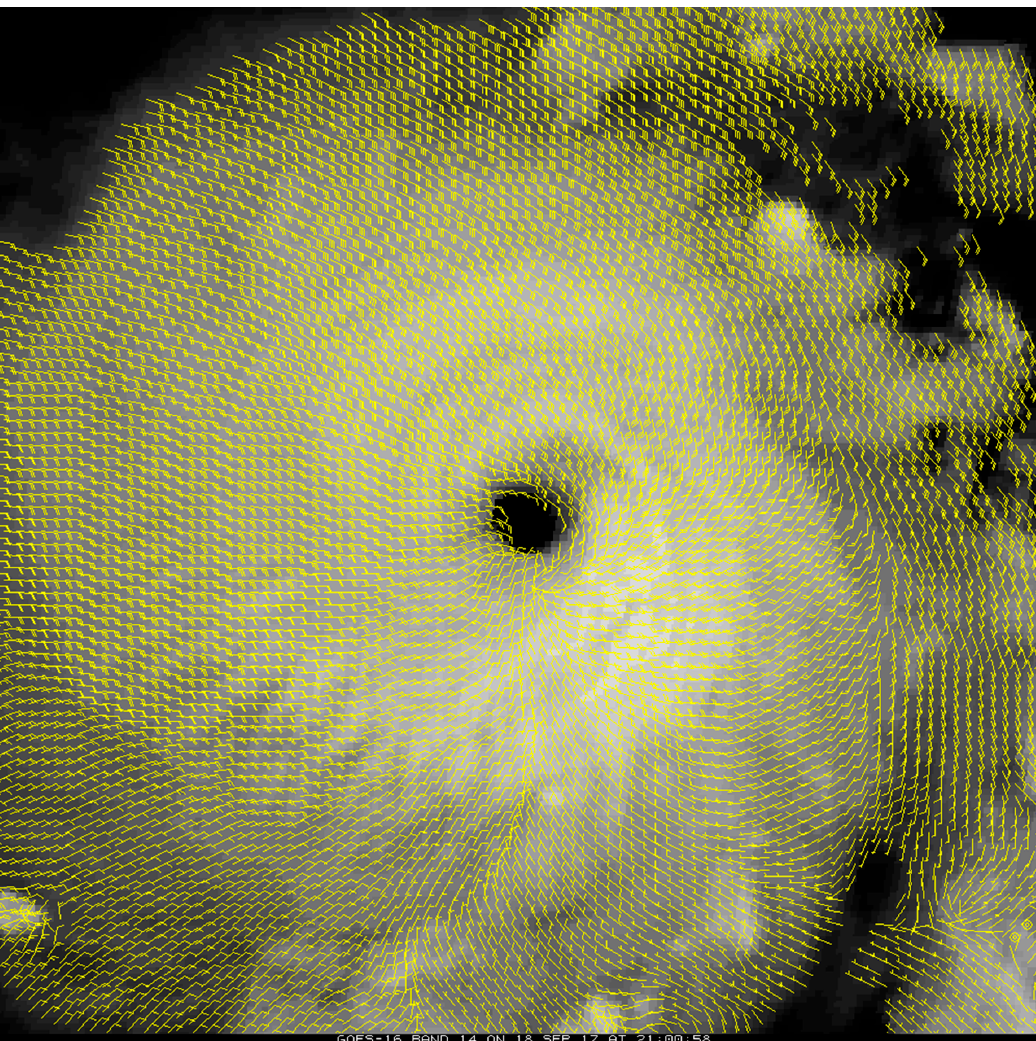
Figure 7. Same Hurricane Maria case as Figures 2–6, but plotted are upper-level AMVs generated with an optical flow technique. The wind flags have been thinned in order to make a distinguishable plot.